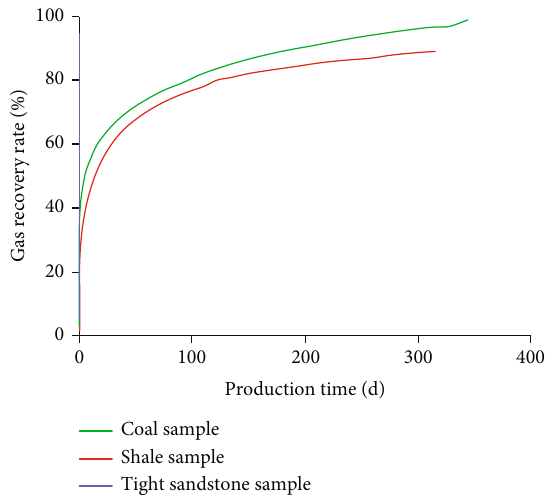
Figure 5: Gas recovery rate versus production